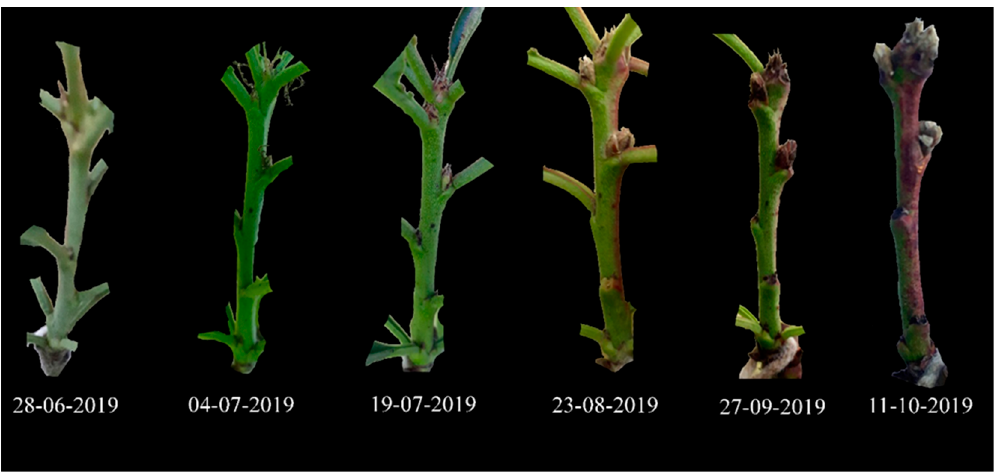
Figure 2. Shoot and bud development of the peach cultivar “ BRS Kampai ” in the tropical area Minas Gerais State, Brazil. The images correspond to the same shoot on six dates from June to October.